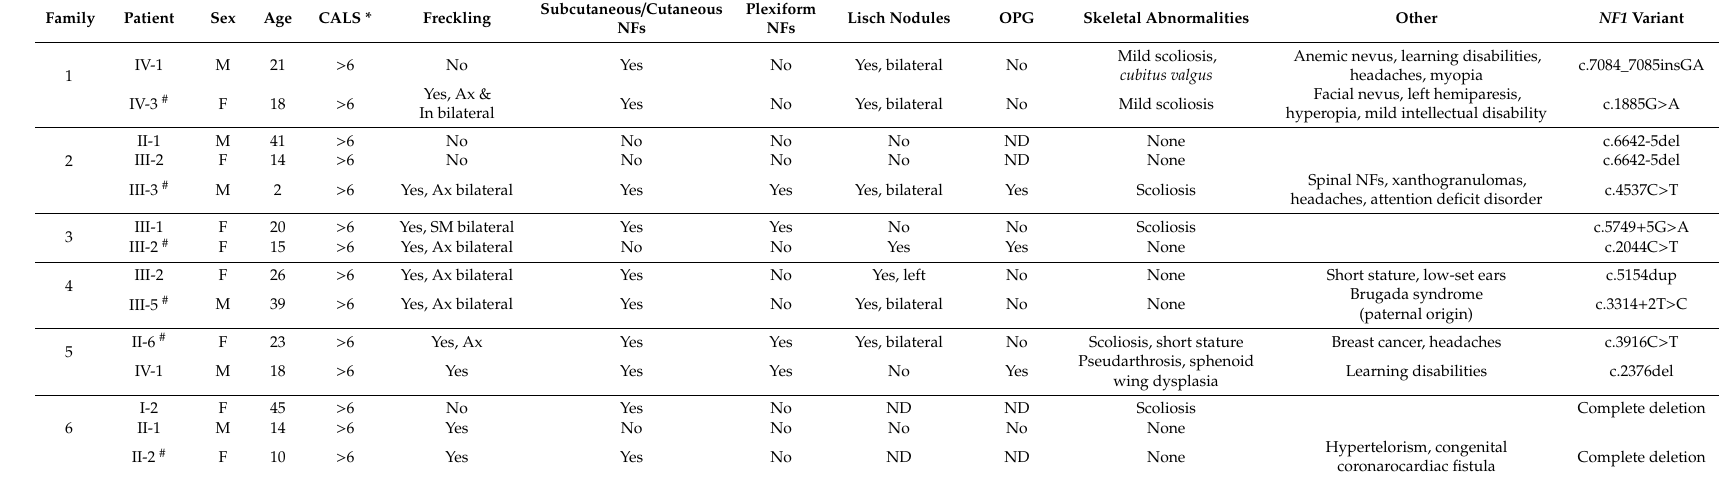
Table 1. Clinical features of the patients with molecular diagnosis of NF1 in the six families.